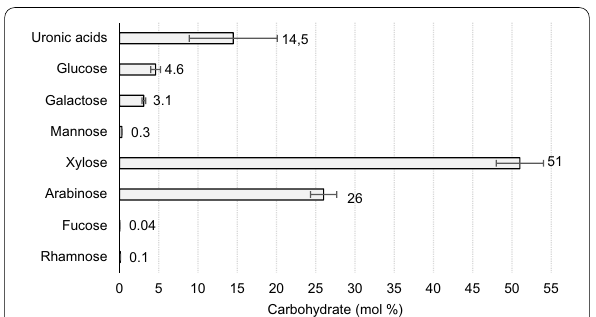
Fig. 2 Glycoside linkage composition (mol %) of the GAX fraction obtained from BSG with 4 M